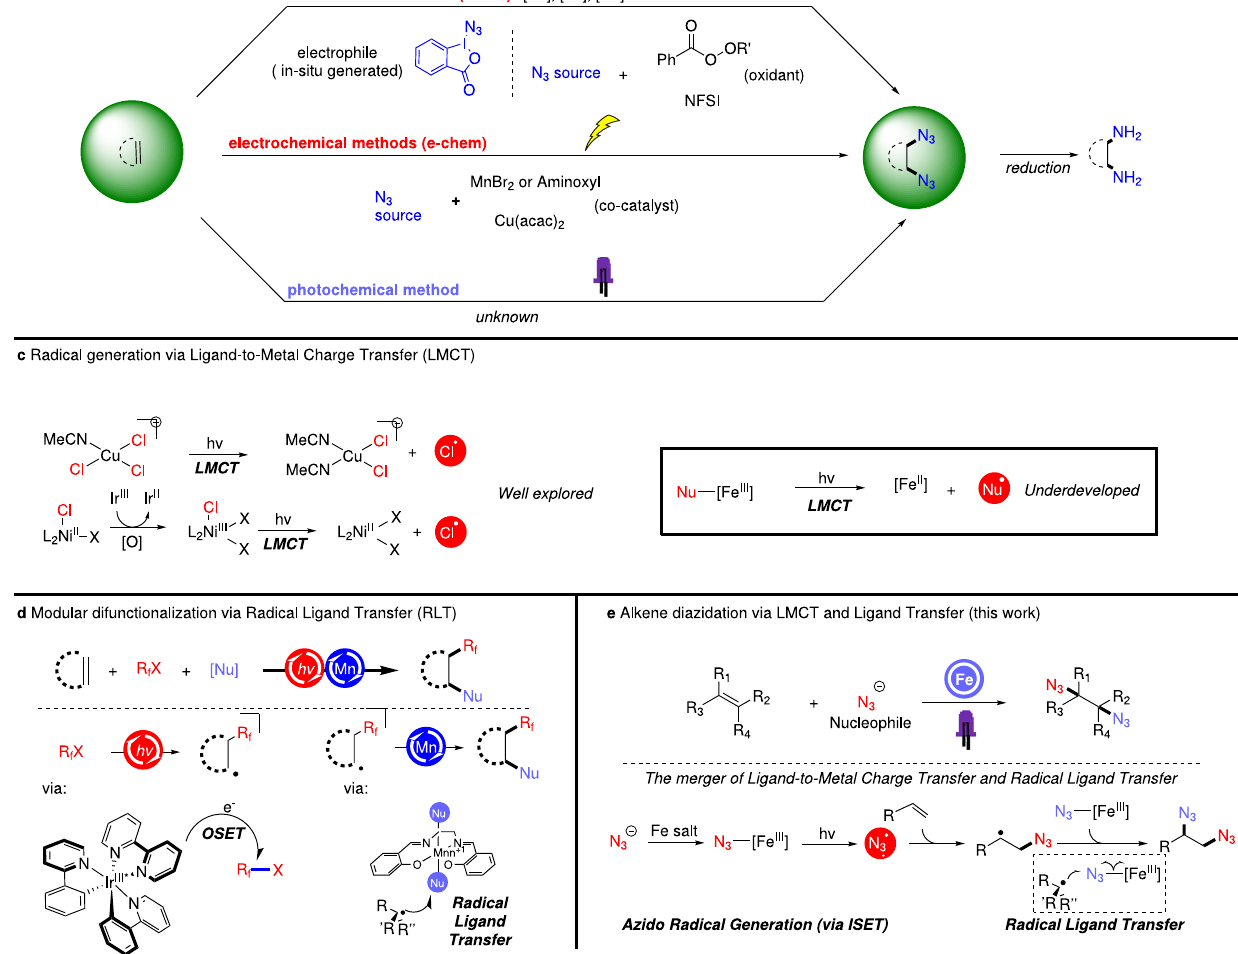
Fig. 1 | Background and project synopsis. a Prevalence of diamine motifs in pharmaceuticals,naturalproducts,andsynthesis. b Previousworksonazidoradical generation via Outer-Sphere single electron transfer (OSET) pathway. c Ligand-to-